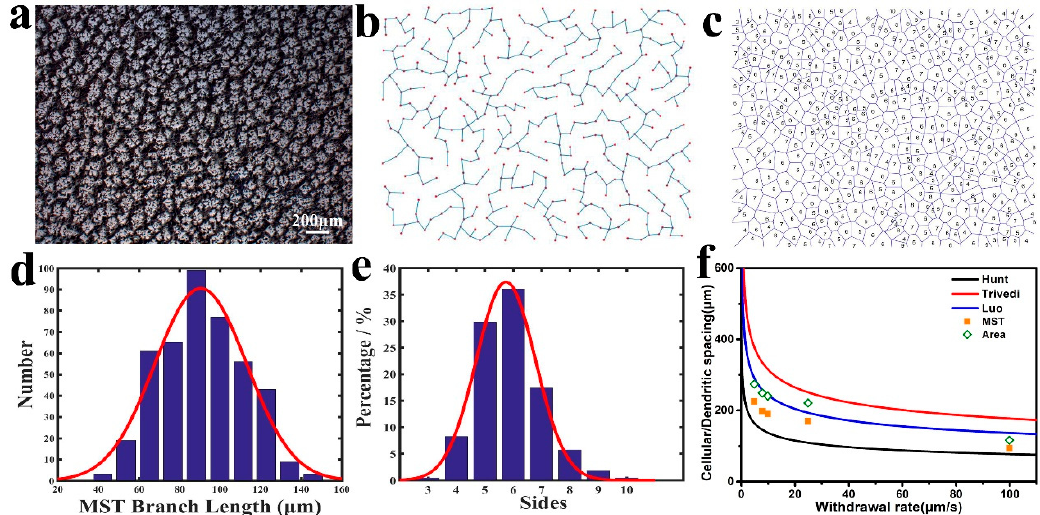
Figure 4. Statistical analysis of cell / dendrite distribution characteristics ( a ) Cross-section structure at a withdrawal rate of 100 µ m / s. ( b ) The minimum spanning tree corresponding to ( a ). ( c ) Voronoi polygon form of ( a ). ( d , e ) Gaussian distribution of minimum spanning tree (MST) and Voronoi polygon statistics. ( f ) Comparison of the experimental dendritic arm spacing and theoretical model.